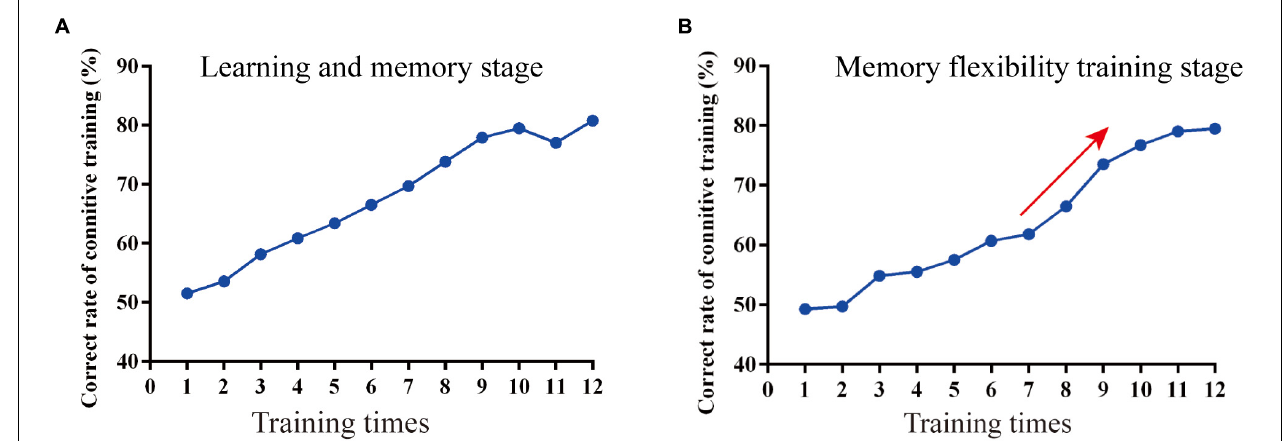
FIGURE 2 | The course of the memory flexibility training in APP/PS1 mice. (A) The correct rate in the learning and memory stage. (B) The correct rate in the memory flexibility training stage.